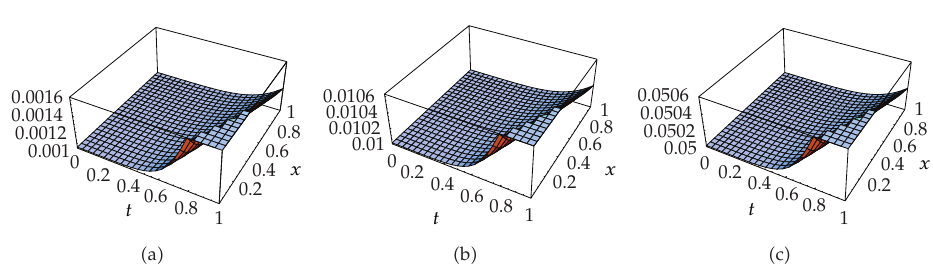
Figure 2: The figure of relative error | (cid:5) u − u 5 (cid:6) /u | with noise σ (cid:4) 0 . 1%, 1%, 5%, respectively, for Example 4.1.